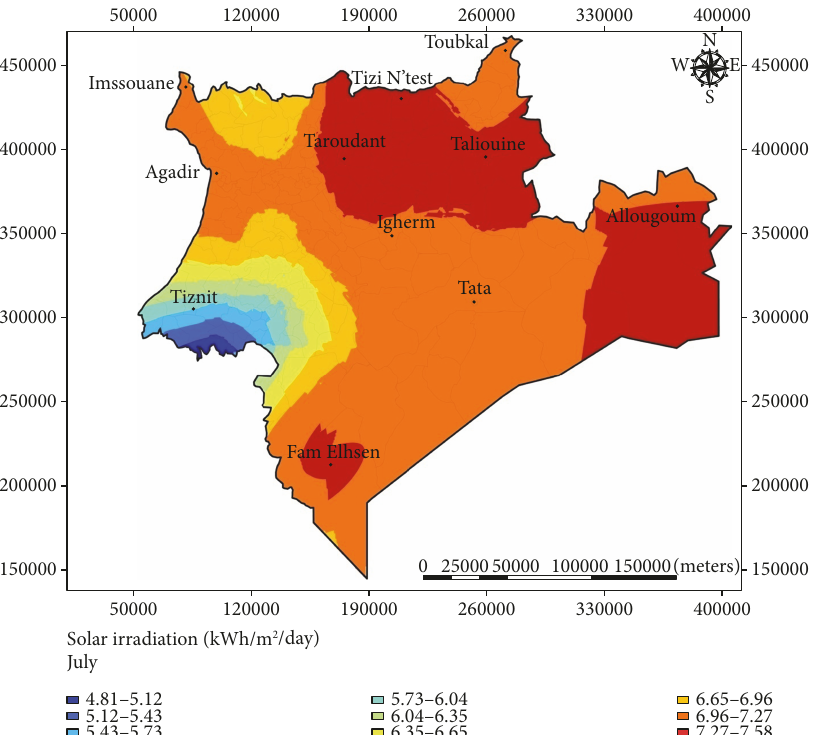
Figure 15: Solar energy potential map of the Souss-Massa area for the month of July as estimated by the ANN and designed with the Kriging interpolation technique.